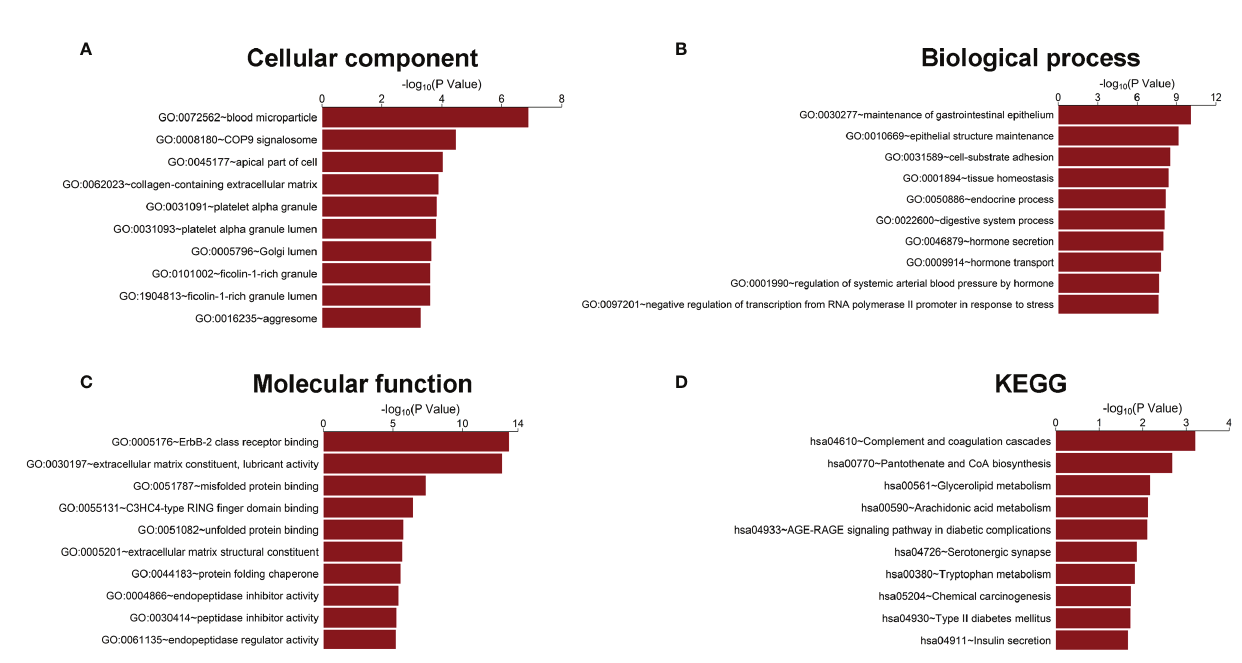
FIGURE 2 | Gene Ontology and KEGG enrichment analysis of DEGs. (A) Cellular component, (B) biological process, (C) molecular function, and (D) KEGG pathway